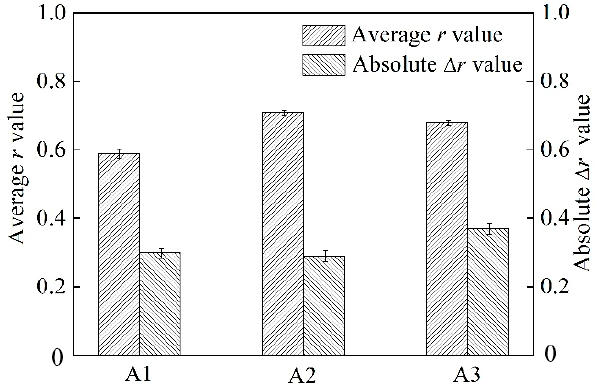
Figure 11. Average r and Δ r values of alloys with T4P state.